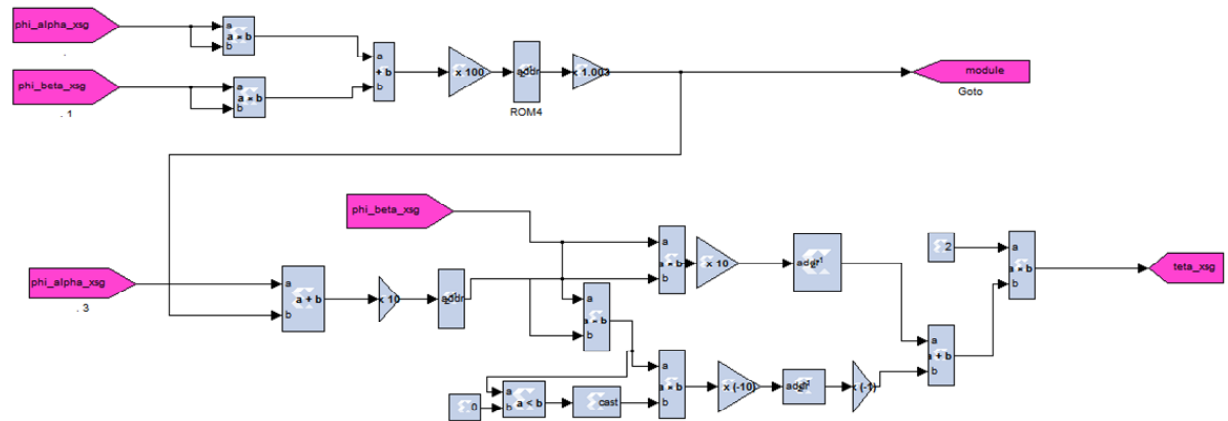
Figure 14. Designed flux angle and magnitude using elementary XSG blocks based on mathematical estimations of the unavailable functions in the Xilinx library.